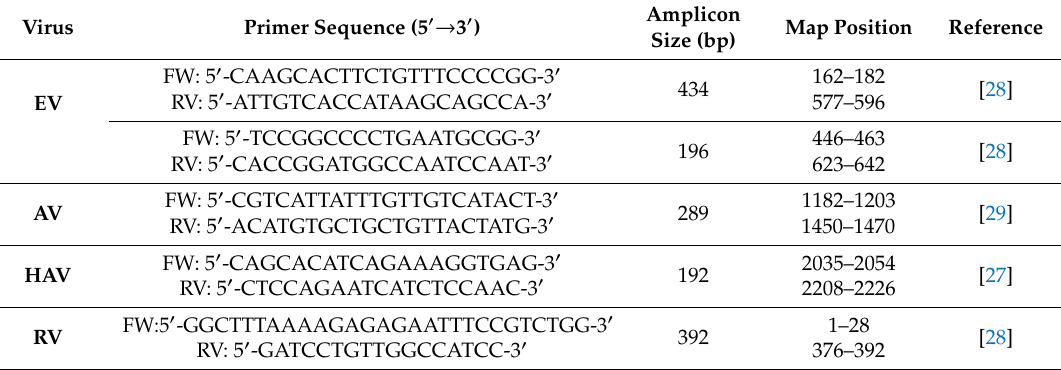
Table 1. PCR primer sequences used for detection of the di ff erent enteric viruses.